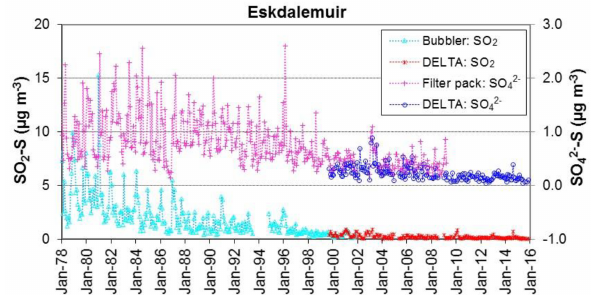
Figure 12. Long-term time series of SO 2 (December 1977– July 1993) and SO 2 − (December 1977–December 2001) concen- 4 trations measured in the UK Acid Deposition Monitoring Net- work (ADMN) (Hayman et al., 2007) and the AGANet DELTA measurements (October 1999–December 2015) at the Eskdale- muir monitoring station (EMEP station code = GB0002R; UK- AIR ID = UKA00130). ADMN values (EMEP, 2017b) are monthly means of daily measurements for SO 2 and SO 2 − by a daily bub- 4 bler and filter pack method, respectively, matched to the AGANet sampling periods (monthly) where the measurements overlap.